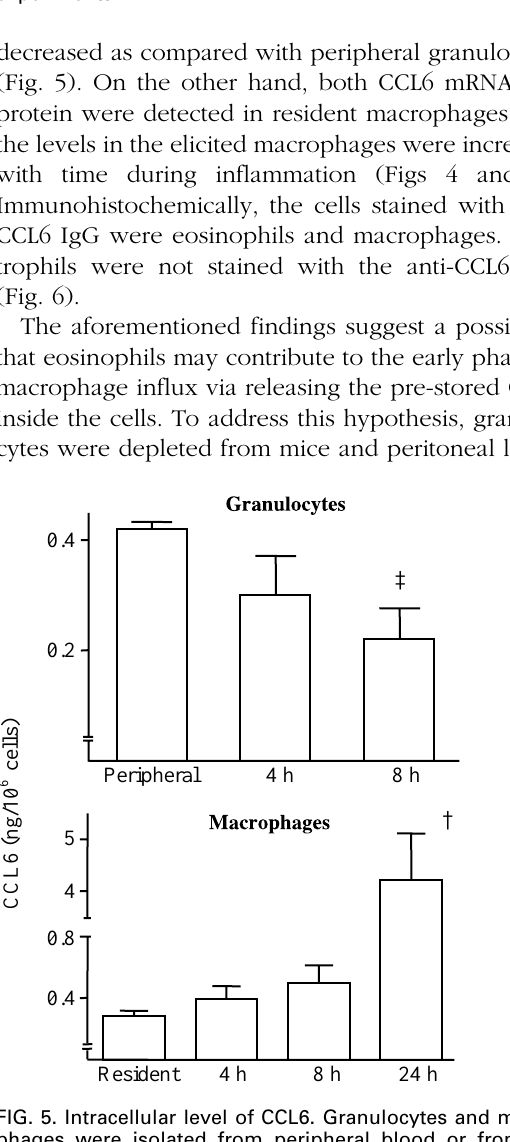
FIG. 4. Expression of CCL6 mRNA in granulocytes and macrophages. Infiltrated granulocytes and macrophages were purified from the elicited leukocytes after thioglycollate injection. Unstimulated granulocytes and macrophages were purified from non-treated peripheral blood and perito- neal cavity, respectively. Total RNA was isolated from the cells and reverse transcribed to cDNA, and the cDNA was amplified by specific primers for murine CCL6 and GAPDH. Shown are representative data from three independent experiments.